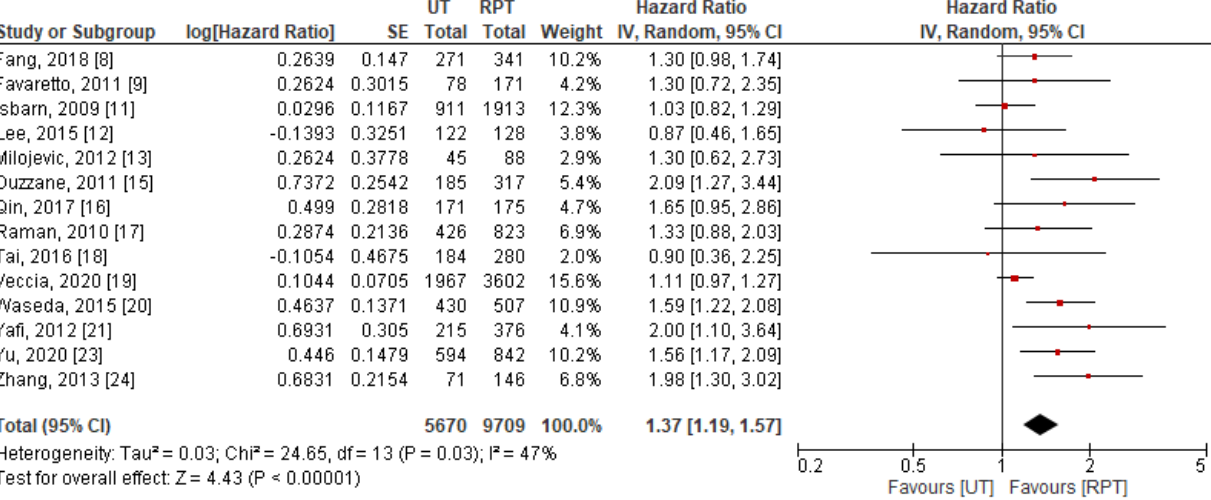
Figure 3. Forest plot and meta-analysis of cancer-specific survival [8,9,11–13,15–21,23,24]. CI = confidence interval; IV = inverse variance; RPT = renal pelvic tumor; SE = standard error; UT = ureteral tumor.